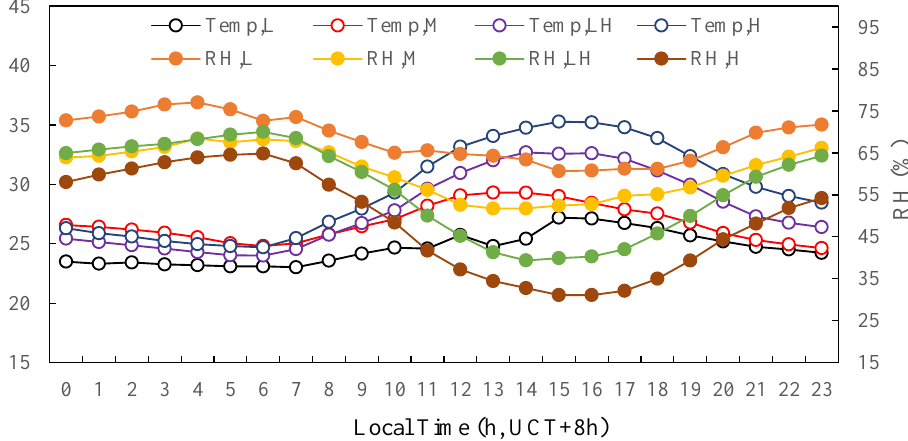
Figure 5. Diurnal variations in ambient temperature and relative humidity under the different photochemical activity levels.